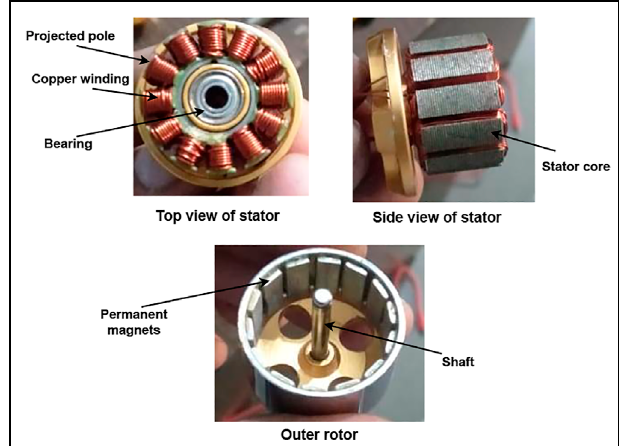
FIGURE 3 | Construction of BLDC